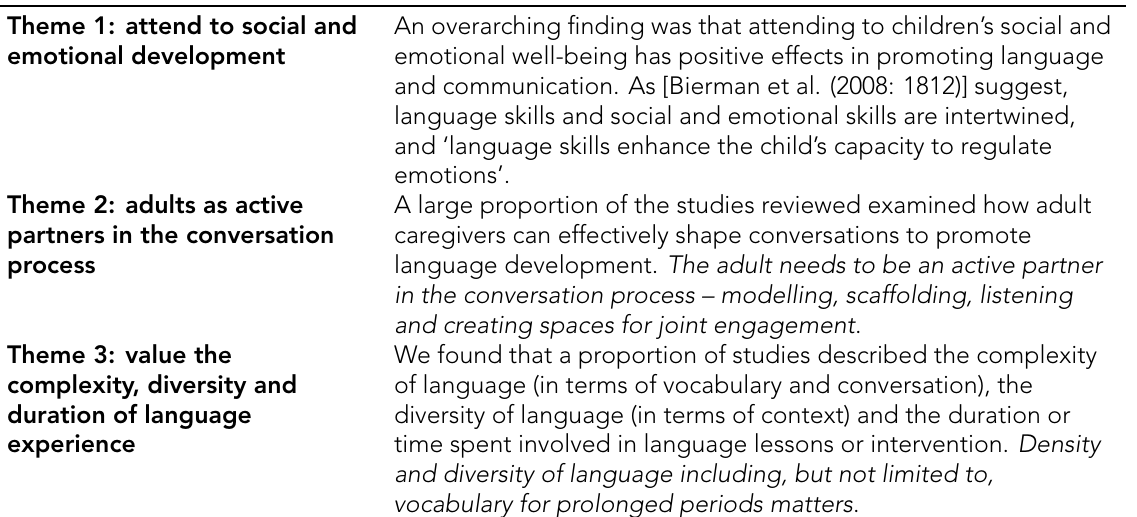
Table 2. Key themes from review findings (Source: authors) Theme 1: attend to social